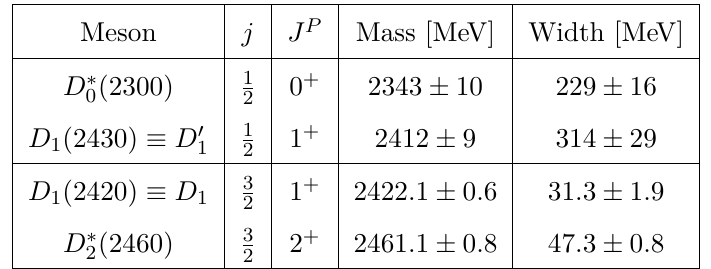
Table 1 . The lowest excited charmed mesons. For definiteness, we quote the masses and total widths of electrically neutral states from